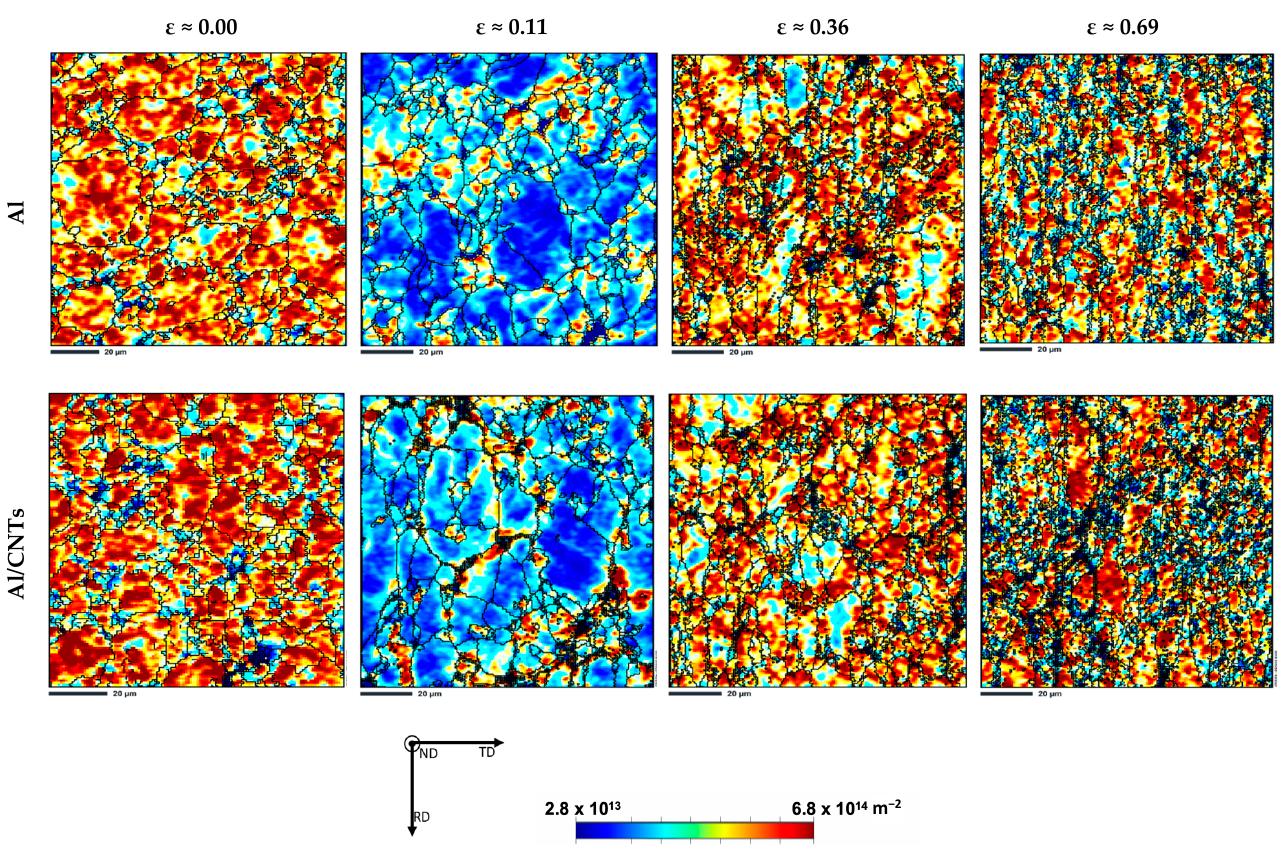
Figure 7. Distribution of Kernel average misorientation (KAM) for Al and Al/CNT samples, cold rolled to strains of 0.11, 0.36, and 0.69.